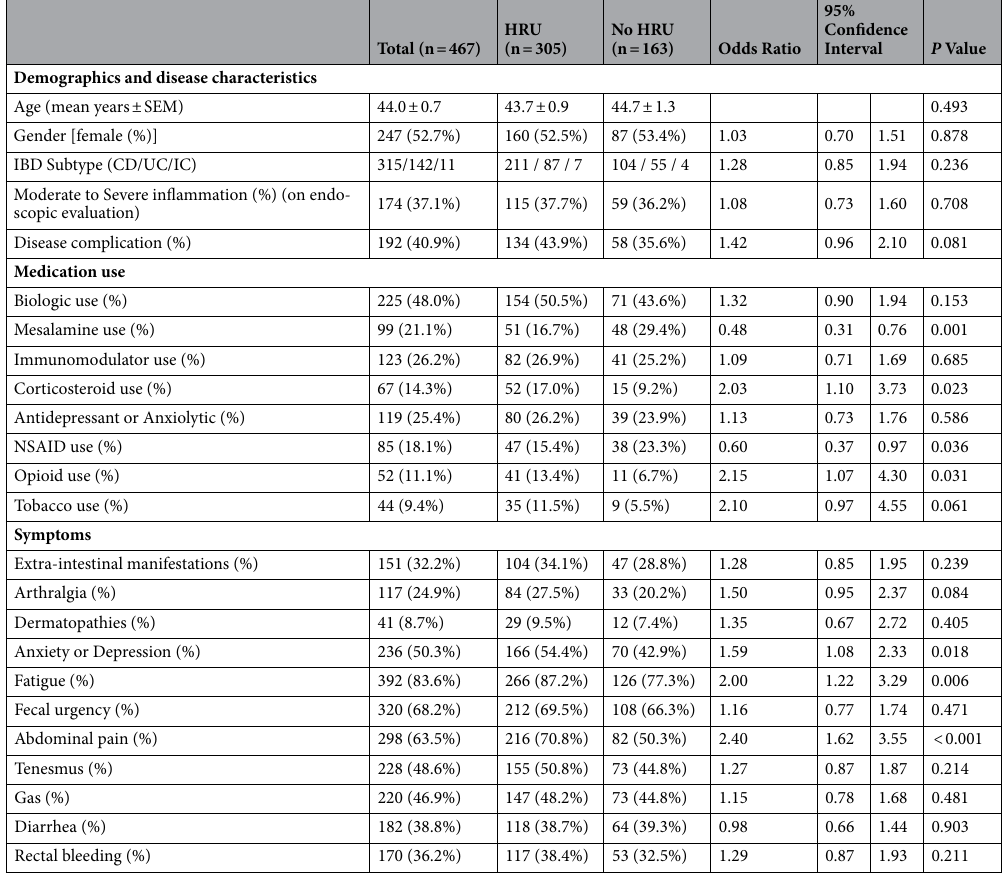
Table 1. Clinical Characteristics of Healthcare Resource Users and Non-Users. HRU = Healthcare Resource Utilization, CD = Crohn’s disease, UC = ulcerative colitis, IC = indeterminate colitis. SEM = standard error measurement. Disease Complication = intra-abdominal stricturing, fistulae and/or abscess. IBD subtype analysis reports OR and CIs for CD vs. UC (excluding patients with